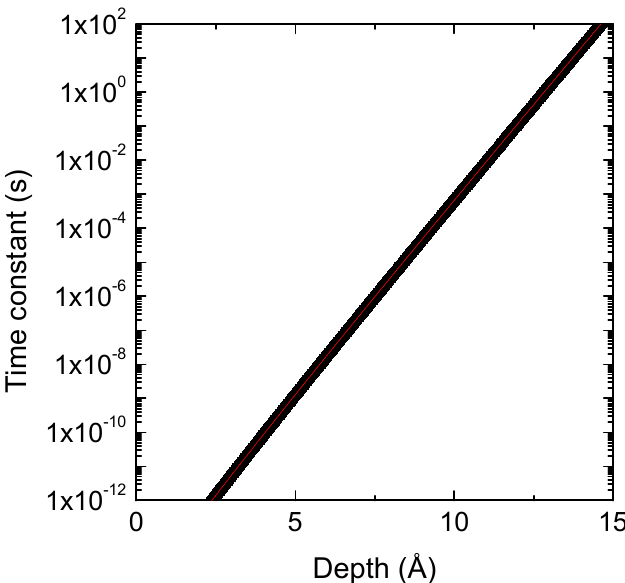
Figure 12. Tunneling time constant obtained varying the depth between the near interface oxide traps (NIOTs) and the SiO 2 /4H-SiC interface. Data calculated from References [52,73] using Equation (5).